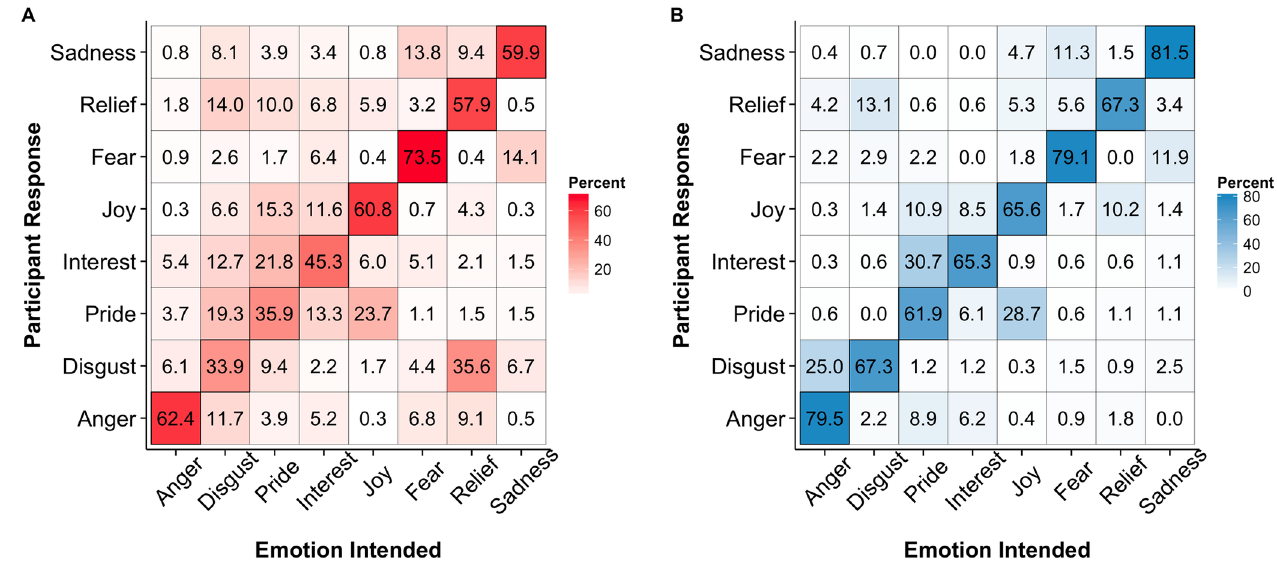
Fig 1. Confusion matrices for a) emotional prosody and b) affect burst tasks. Percentages indicate percent of responses given for each intended emotion, i.e., 14% of the time participants gave the response “ relief ” in the emotional prosody condition, the intended emotion was “ disgust. ”